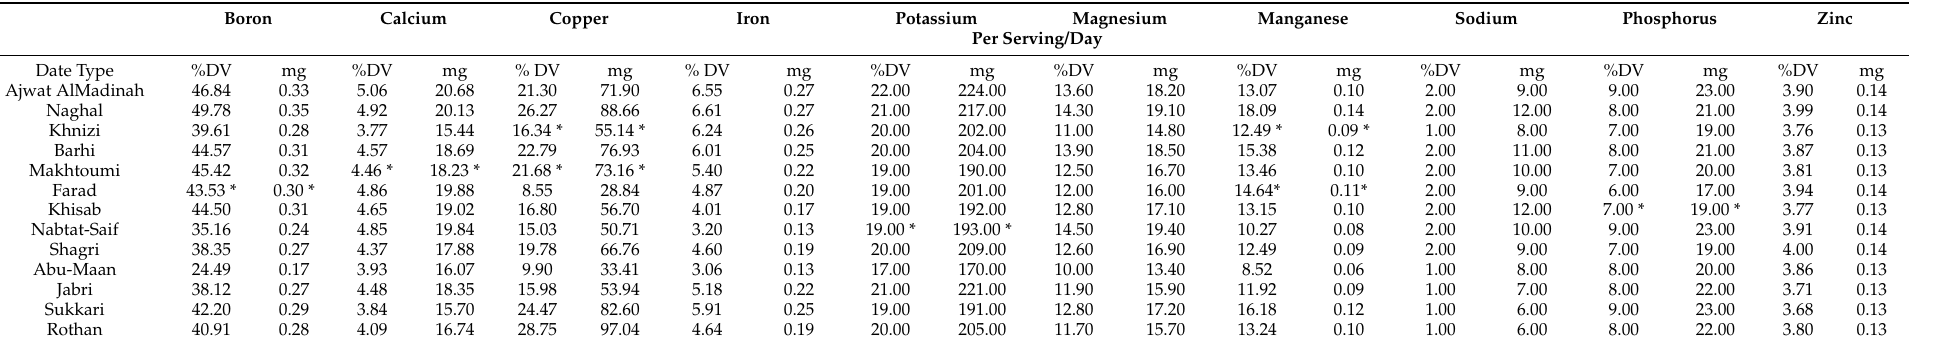
Table 3. Percent Daily Values (%DV) and mg/serving of each mineral in date varieties at different